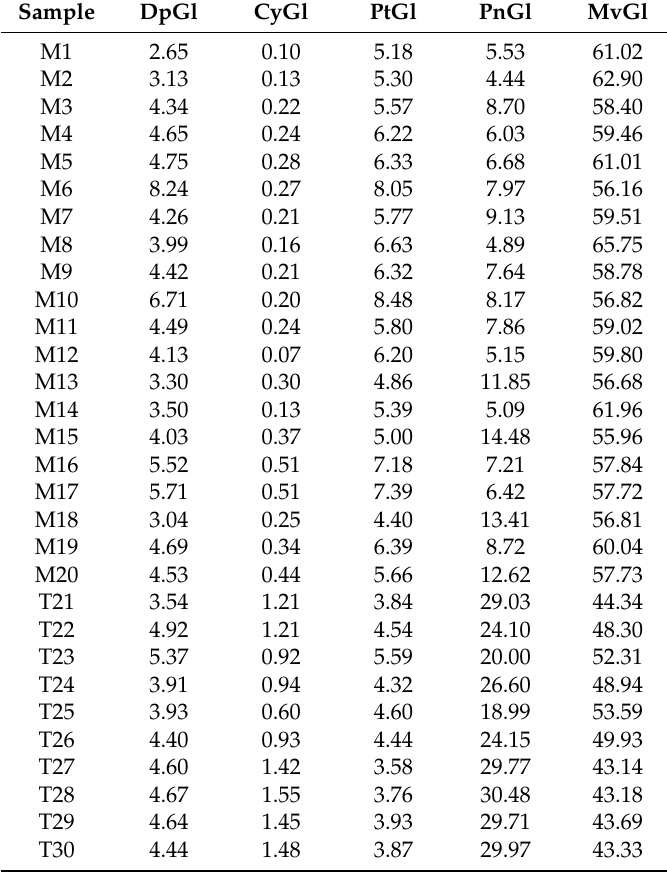
Table 5. Relative content (%) of anthocyanidin monoglucosides in Mencia (M) and Alicante Bouschet (T) young red wines. For key to substances, see text.